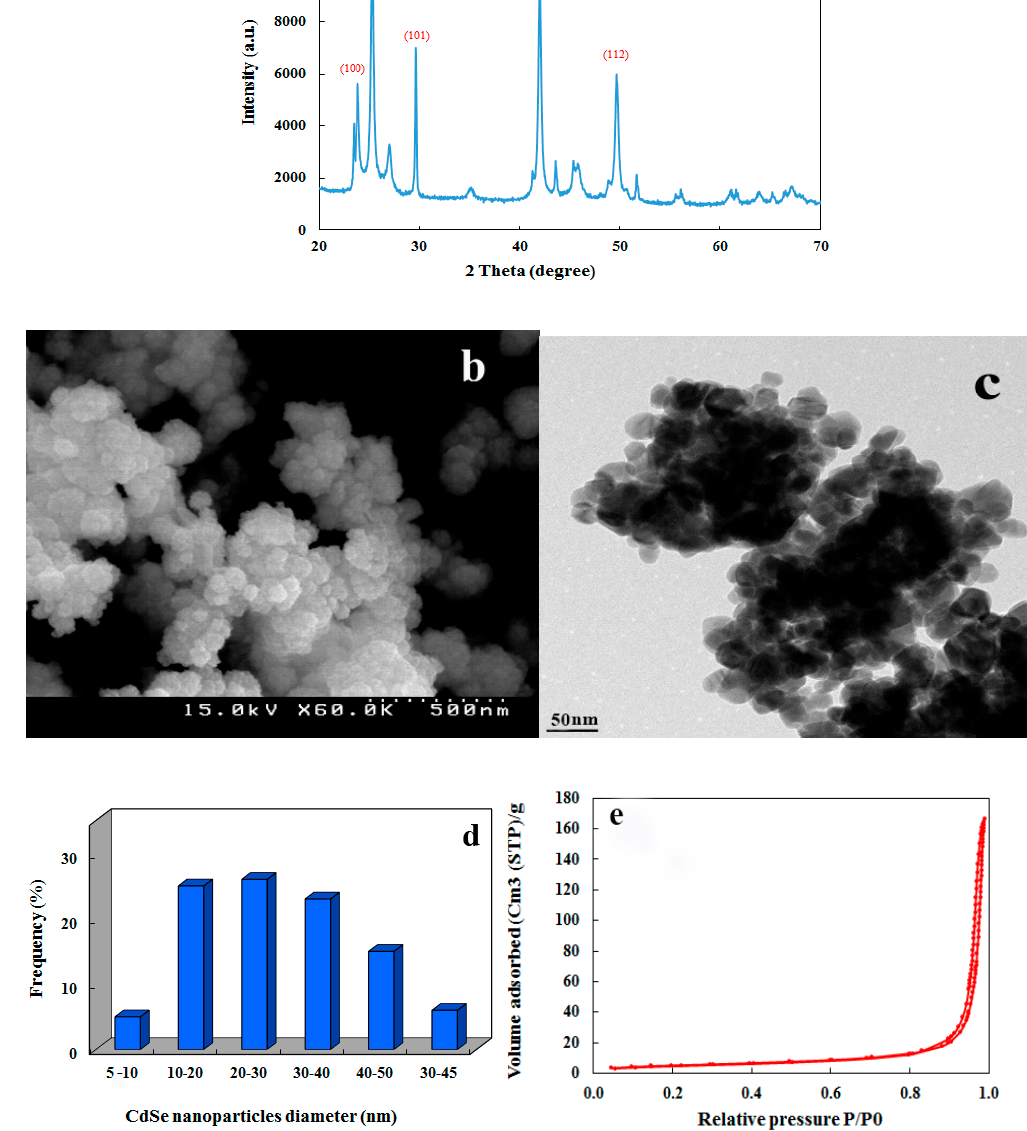
Figure 1. ( a ) XRD pattern of synthesized cadmium selenide nanoparticles (CdSe NPs) with simple hydrothermal method ( b , c ) SEM and TEM images of synthesized CdSe NPs ( d ) Various diameter distribution of synthesized CdSe NPs ( e ) N 2 adsorption-desorption isotherms of CdSe NPs.